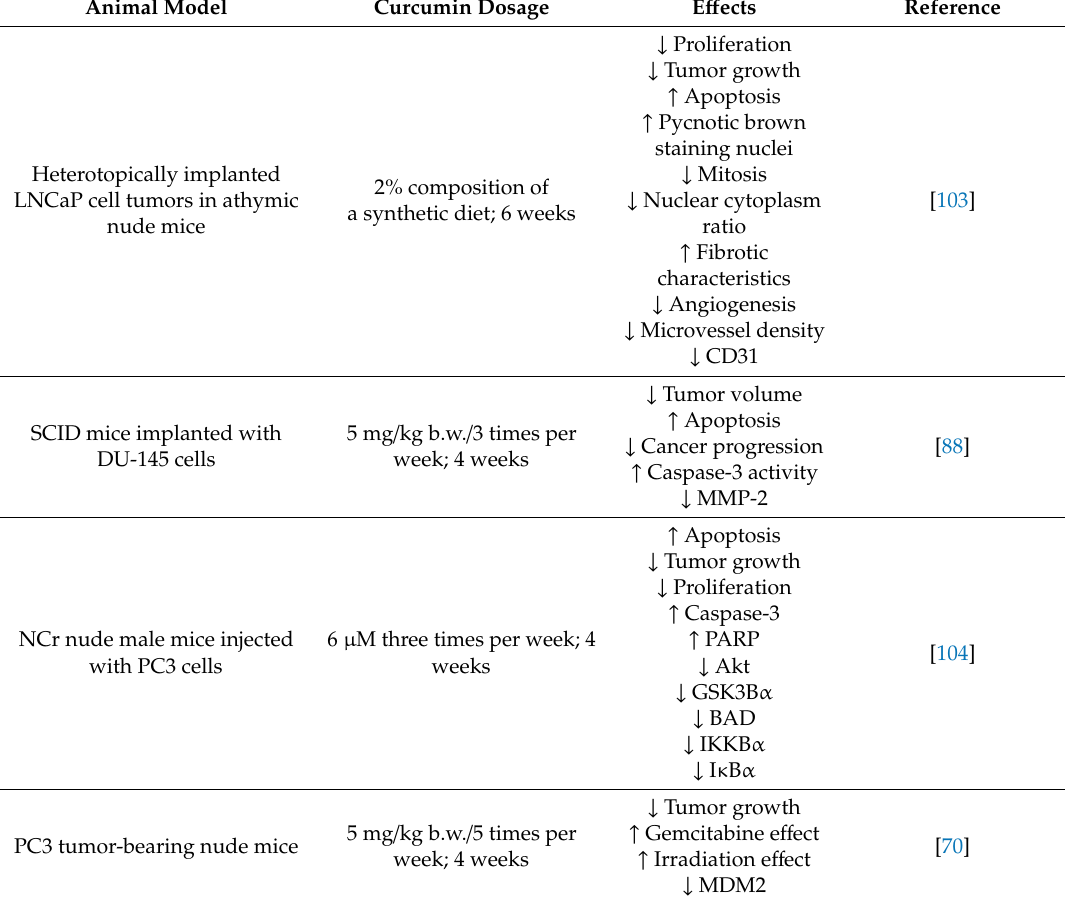
Table 6. In vivo evidence of the e ff ects of curcumin on prostate